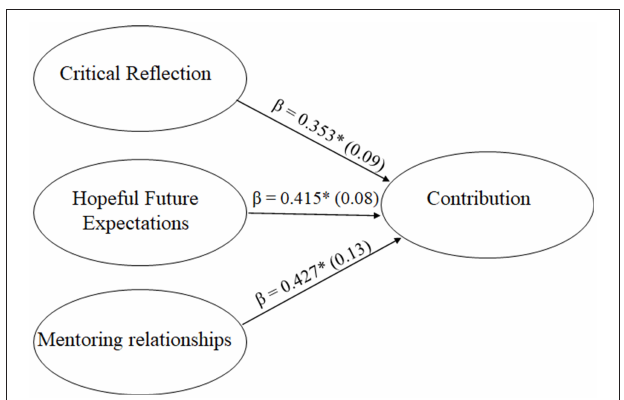
FIGURE 2 | Structural Model. Standardized regression coefficients are depicted for each path, with significant paths at the p < 0.05 level denoted by an asterisk (*).